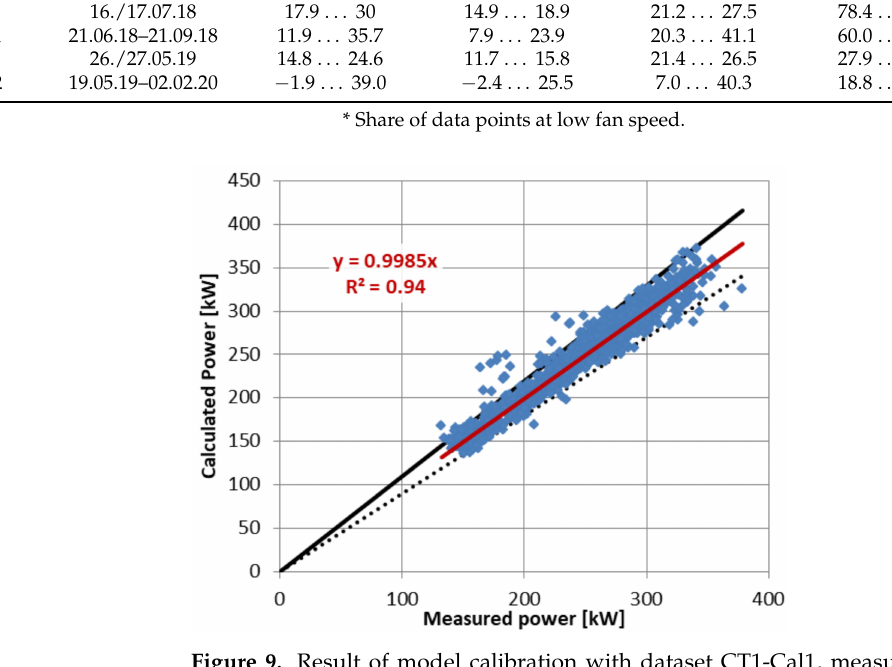
Figure 9. Result of model calibration with dataset CT1-Cal1, measured vs. calculated thermal power of cooling tower (2.2% outside +/ − 10% boundary); black solid/dotted lines show +/ − 10% boundaries.